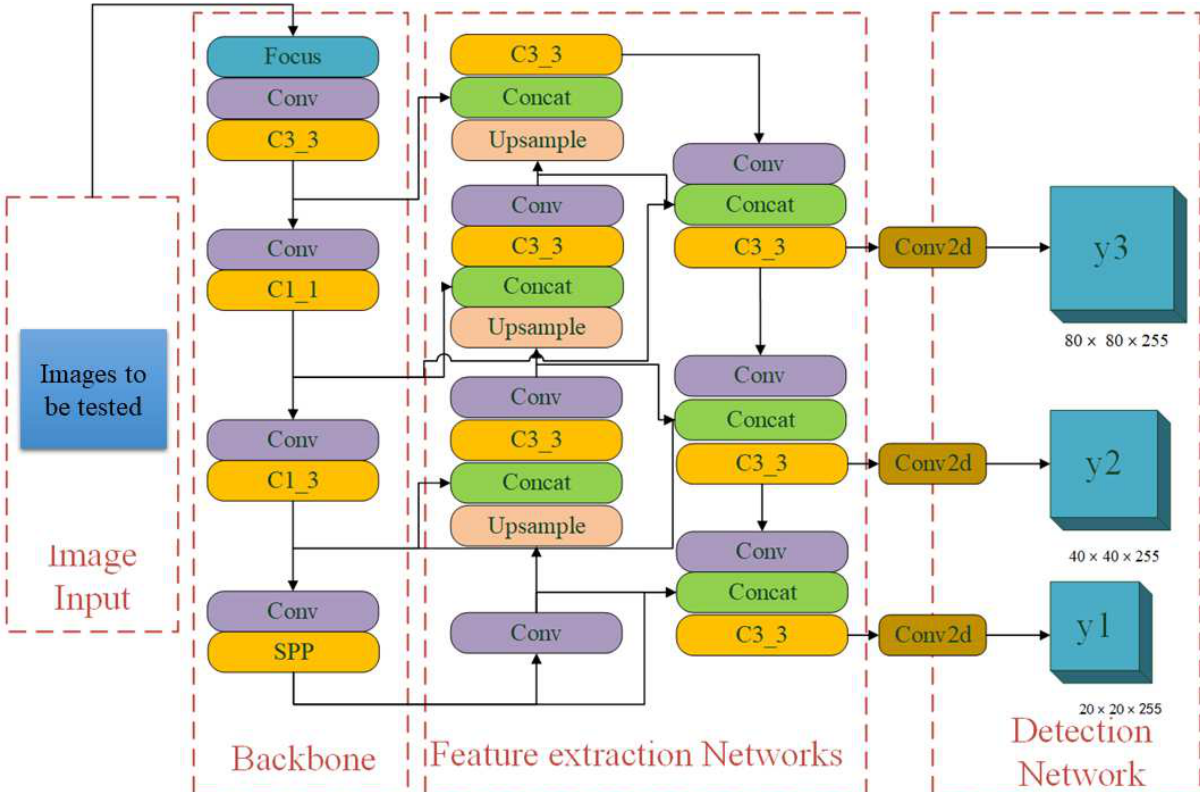
Figure 1. The flow chart of BE-YOLOv5S network structure. (The data transmission process goes through Image Input, Backbone, Feature extraction Network’s and Detection Network from left to right respectively).